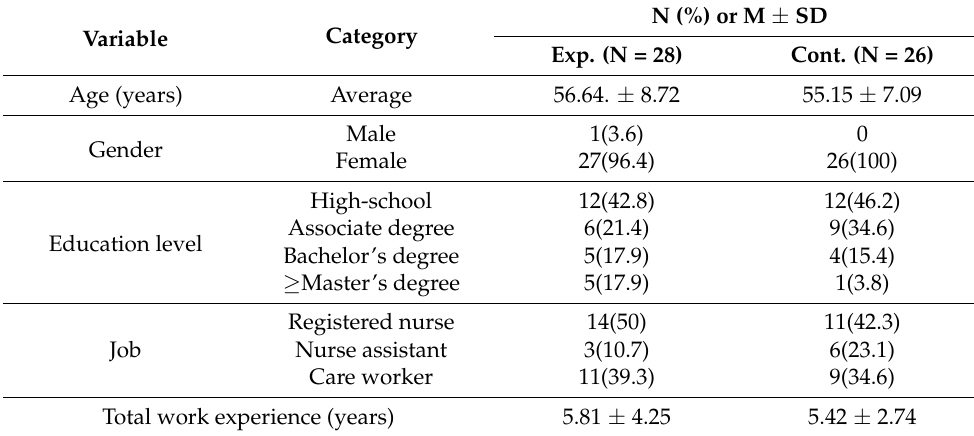
Table 2. General characteristics of the participants (N = 54).